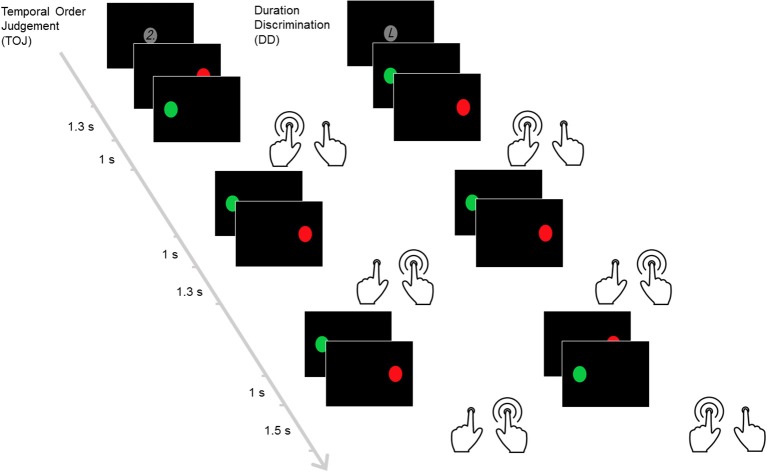
The time discrimination task. This figure illustrates the temporal order judgement and duration discrimination blocks within the task. In this task, pairs of circles (red and green) are presented sequentially. Each temporal order judgment block begins with a screen showing the number “2.” In this block, participants are required to identify the circle that appears at later time between the pairs. Each duration discrimination block starts after the letter “L” is displayed instead. The participants are required to identify the circle that appears for longer duration between the pairs.